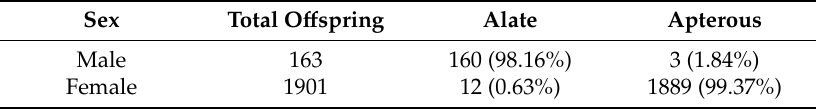
Table 7. Wing dimorphism among adult o ff